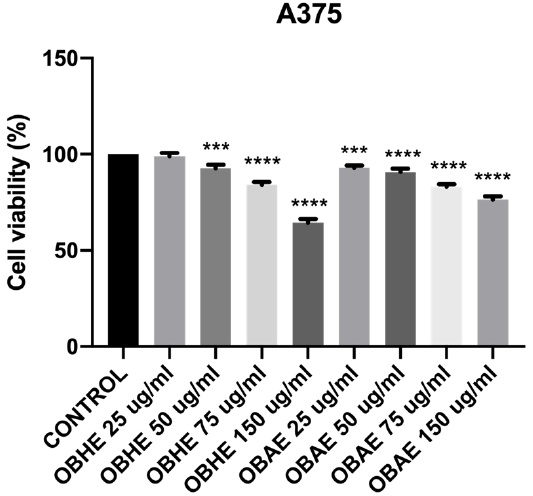
Figure 3. Viability percentage of human melanoma A375 cells after stimulation with basil hydro-alcoholic extracts (25, 50, 75 and 150 μg/mL), at 24 h post-stimulation. The results are expressed as cell viability percentage (%) normalized to control cell. The data represent the